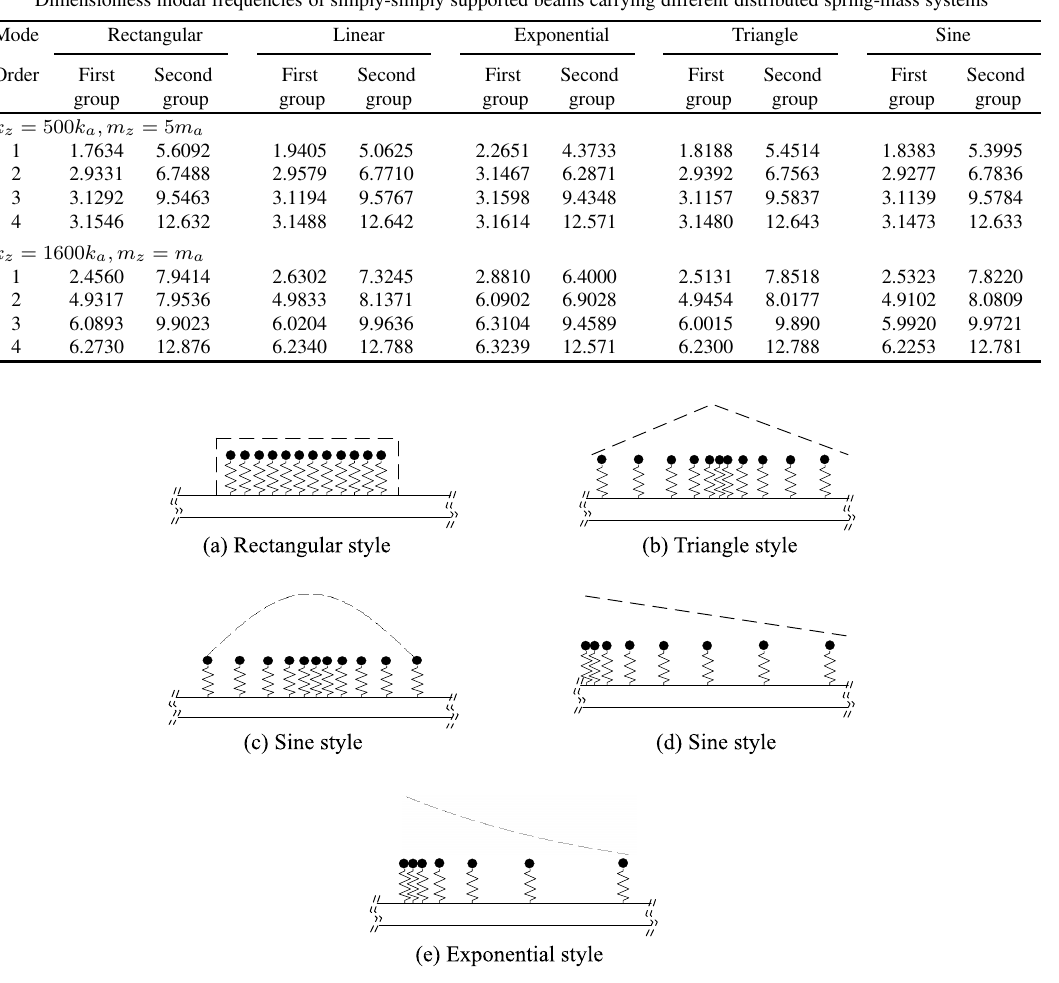
Fig. 2. Sketch of five